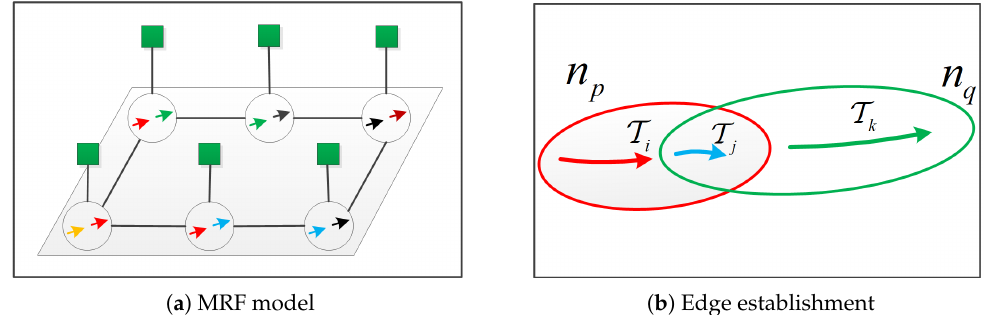
Figure 5. The proposed Markov random field model. In ( a ), the circle represents the node, while the block represents the observation information. The line between nodes is an edge; an edge holds only when two nodes contain the same tracklet coupling and the common tracklet coupling is in the middle position in the time relationship, as illustrated in ( b